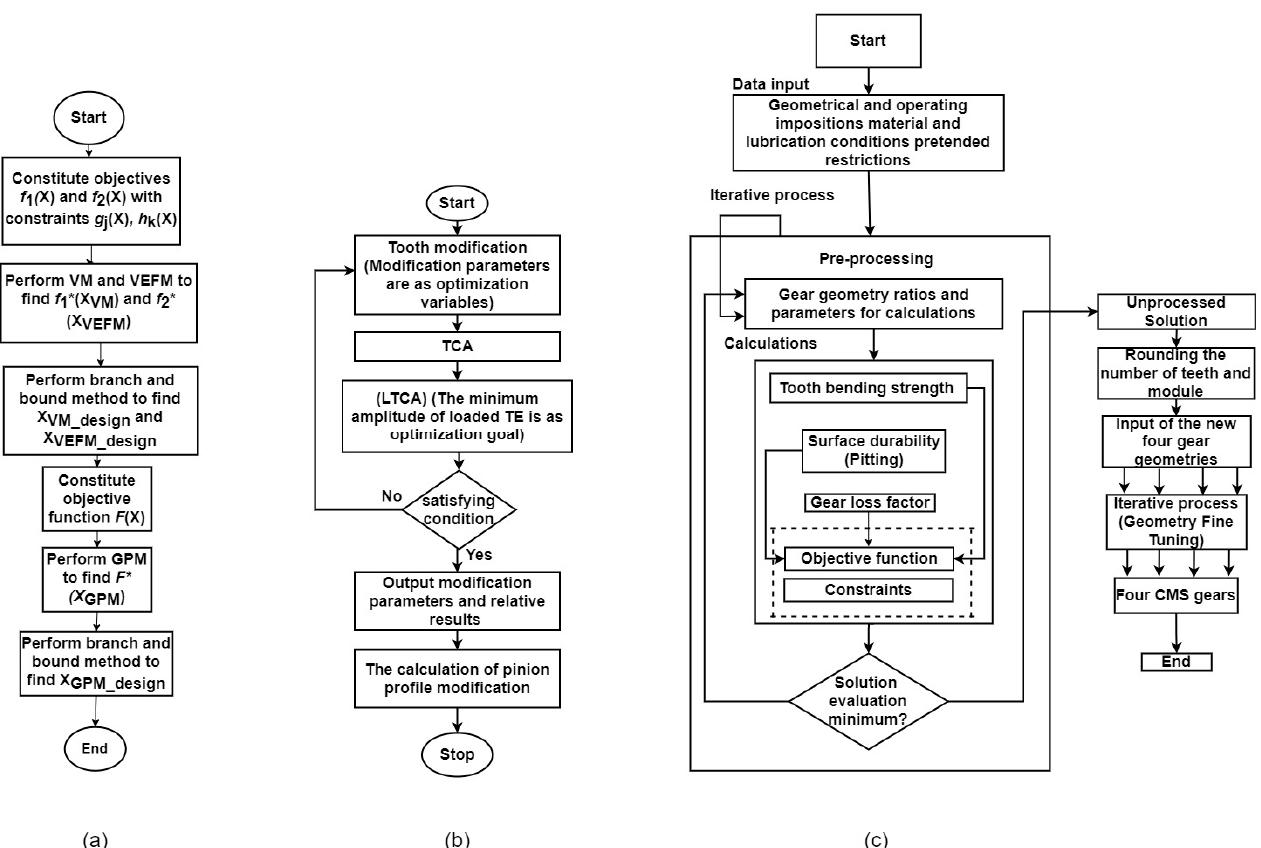
Figure 4. Design processes of helical gears that consider the minimization of vibration as a design goal. ( a ) The design process of cylindrical gear pairs for the reduction of gear size and meshing vibration [112]. ( b ) Modified optimization of double helical gears (Reprinted with permission from ref. [115]. 2021 SAGE Publications). ( c ) Algorithm for generating CMSG (constant mesh stiffness gears) (Reprinted with permission from ref. [13]. 2021 Elsevier) .